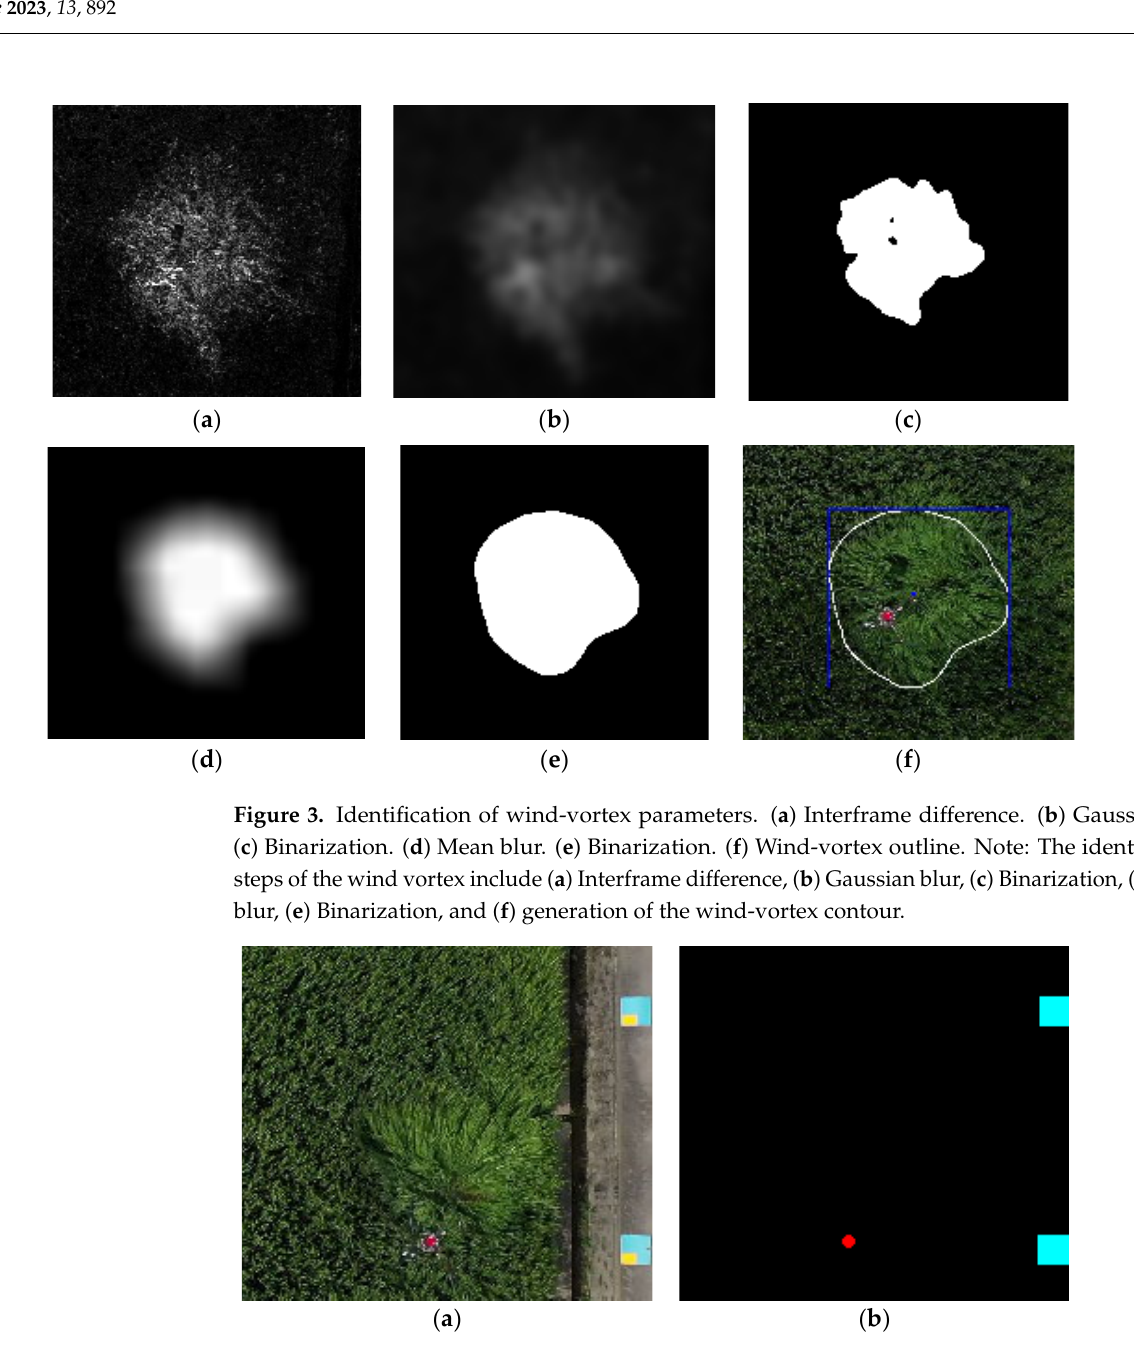
( b ) Figure 2. Experimental process and method of recording wind-vortex image. ( a ) Experimental method. ( b ) Aerial imagery. We used C++ programming language and OpenCV3 computer vision library for im- age processing to obtain wind -vortex information. The rice stems and leaves in the wind- vortex area swung violently under the interaction of airflow and rice, which was used as an image feature. The region of rice osci llating violently in the field was obtained by using the interframe difference method, namely, the region of the wind vortex. The specific pro- cess involved ( i) using the interframe difference method to identify the disturbance of rice in the image, ( ii) obtaining the wind vortex in the form of scattered points, and (iii) per- forming the Gaussian blur, binarization, mean blur, and binarization again on the scat- tered points to obtain the wind -vortex outline, as shown in Figure 3. The boundary of the identified wind vortex can be changed by adjusting the threshold of fuzzification and bi- narization algorithms. The threshold of the algorithm is adjusted according to the wind vortices visible to the human eye, so that the shape and size of the wind vortices output